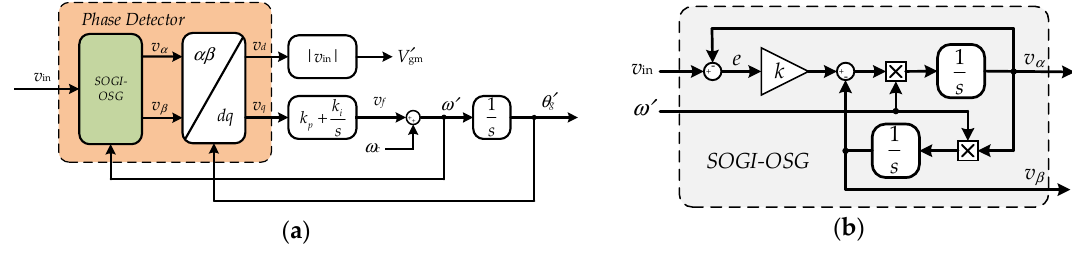
Figure 5. General structure of the Second-Order Generalized Integrator-based PLL (SOGI-PLL): ( a ) entire PLL structure; ( b ) the orthogonal signal generator (OSG)-based Phase Detector (PD).